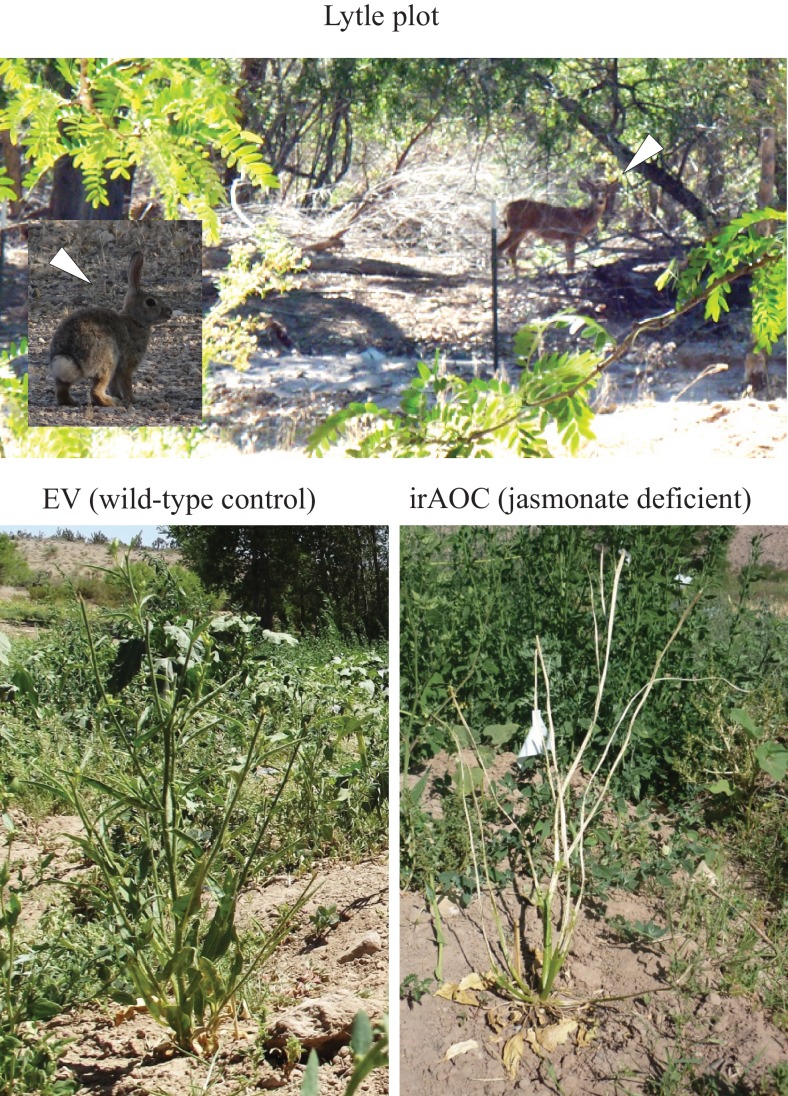
Photographic evidence of herbivore damage and the associated herbivores in the Lytle plot.Mule deer and cottontail rabbits were regularly encountered in the vicinity of the Lytle plot (Top, white arrows). Bottom left: Typical EV plant in the Lytle plot, with partial defoliation. Bottom right: IrAOC plant that was completely defoliated and stem-peeled by vertebrate browsing. Stem peeling is typically caused by mountain cottontail rabbits (Sylvilagus nuttallii), black-tailed jackrabbits (Lepus californicus) and woodrats (Neotoma spp.). Cottontail rabbit picture by Pavan Kumar.